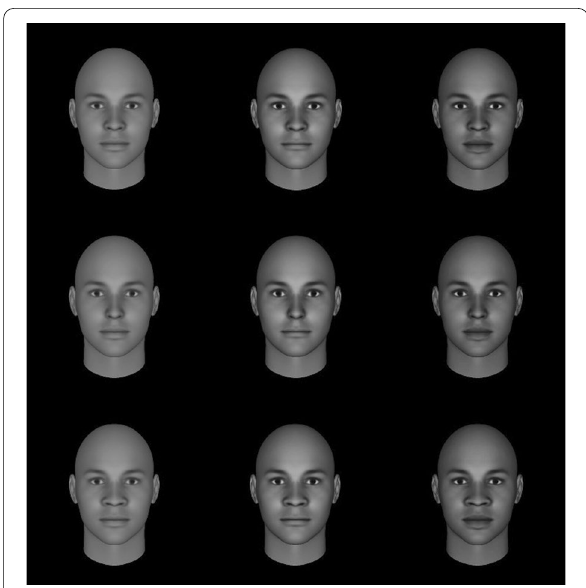
Fig. 1 Sample stimuli. Top row from left to right : Baseline face (average nose and average lips); average nose and thin lips; average nose and full lips. Middle row from left to right : Thin nose and average lips; thin nose and thin lips; thin nose and full lips. Bottom row from left to right : Wide nose and average lips; wide nose and thin lips; wide nose and full lips. Each column from left to right : no reflectance, medium reflectance, high reflectance. Participants viewed full color images of the